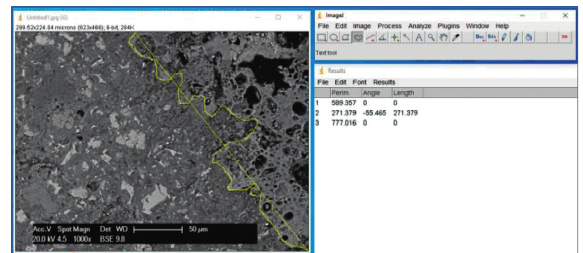
Figure 6: Roughness measurement by ImageJ software on the image of scanning electron microscopy (scale: 299 × 224